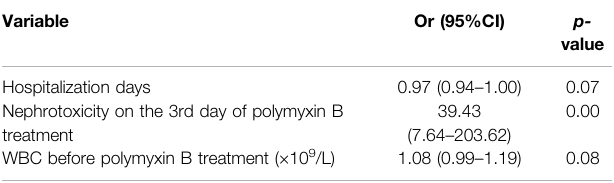
TABLE 6 | Multivariate analysis of late